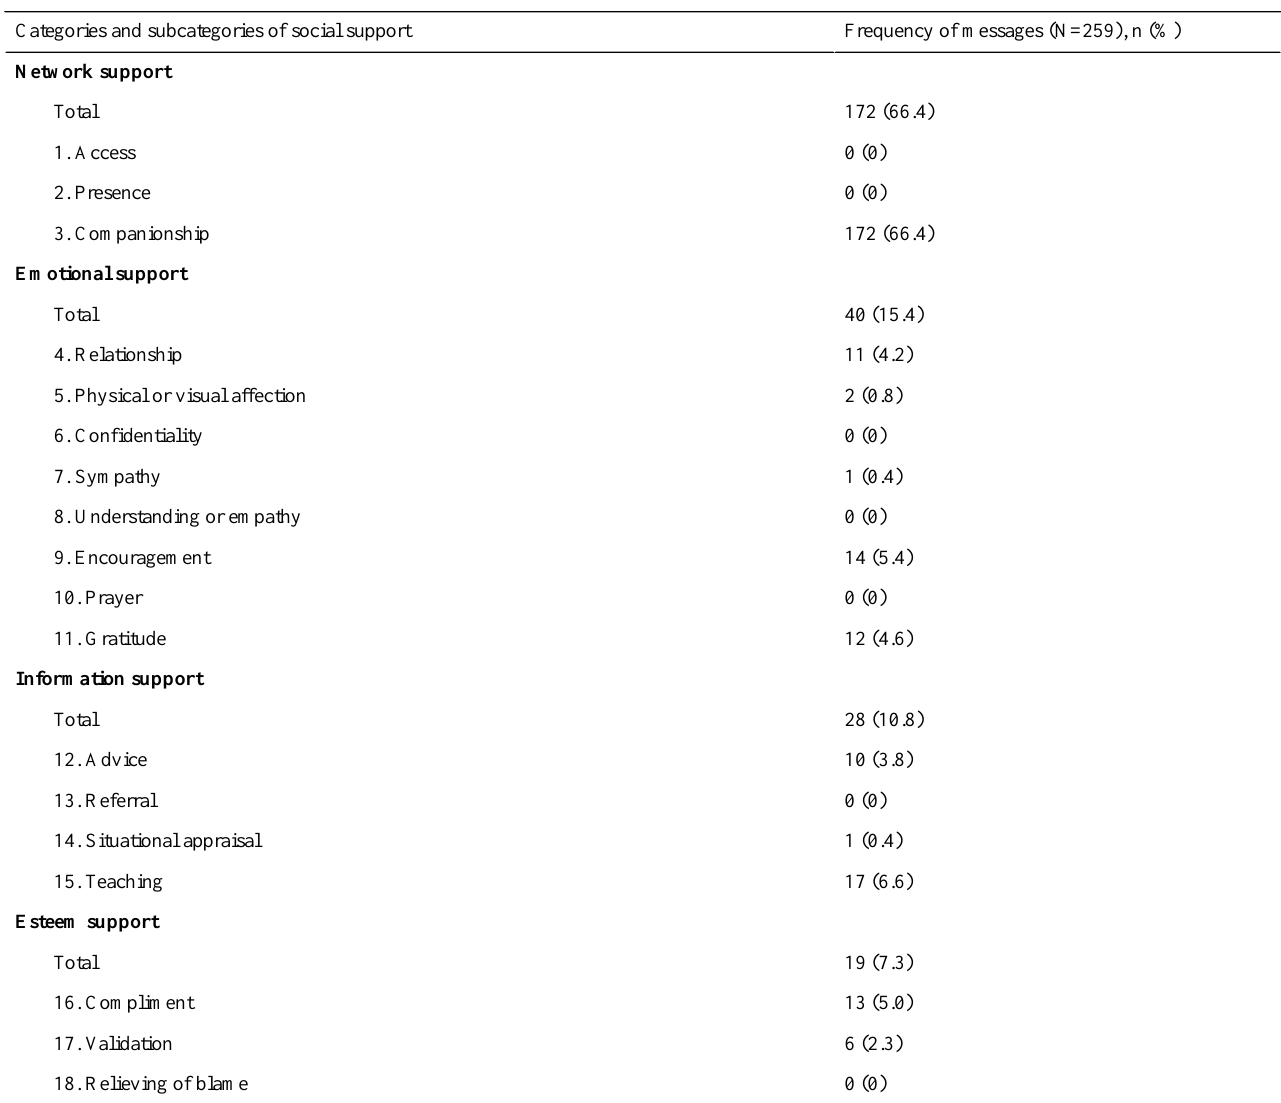
Table 1. Conceptual definitions of social support and frequency of messages of each